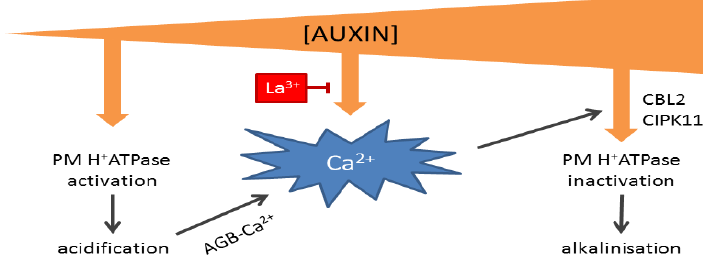
Figure 2. Hypothetical model of auxin concentration-dependent control over apoplastic pH. At low concentrations, auxin activates plasma membrane (PM) H + ATPases, thereby lowering apoplastic pH and increasing apoplastic Ca 2+ concentrations via arabinogalactan glycoproteins (AGBs). At high auxin concentrations, auxin induces a Ca 2+ signal